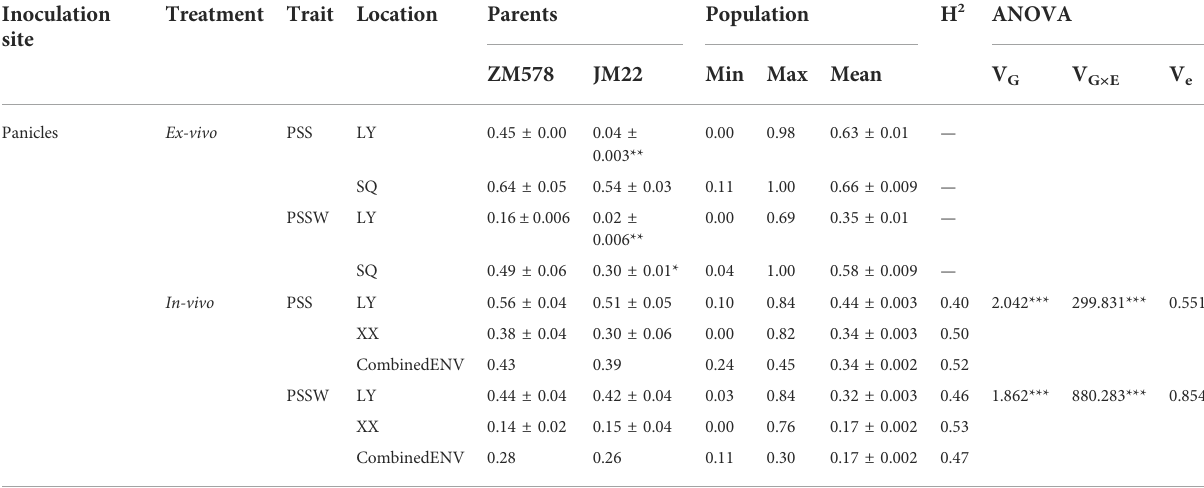
TABLE 1 Phenotypic variation, heritability (H 2 ) and ANOVA analysis of PSS and PSSW for ZM578, JM22, and the derived RILs in Ex-vivo and In-vivo inoculation treatment in different locations. Inoculation Treatment Trait site